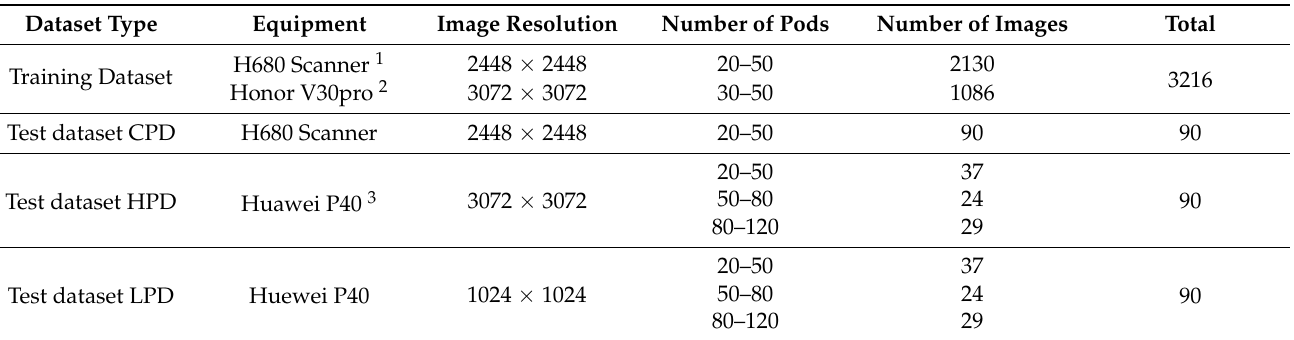
Figure 3. Samples of the soybean pods from different datasets: ( a ) test dataset CPD (color-distorted pod image dataset), ( b ) test dataset HPD (high-density pod image dataset), and ( c ) test dataset LPD (low-pixel pod image dataset). Table 1. Images of different datasets.